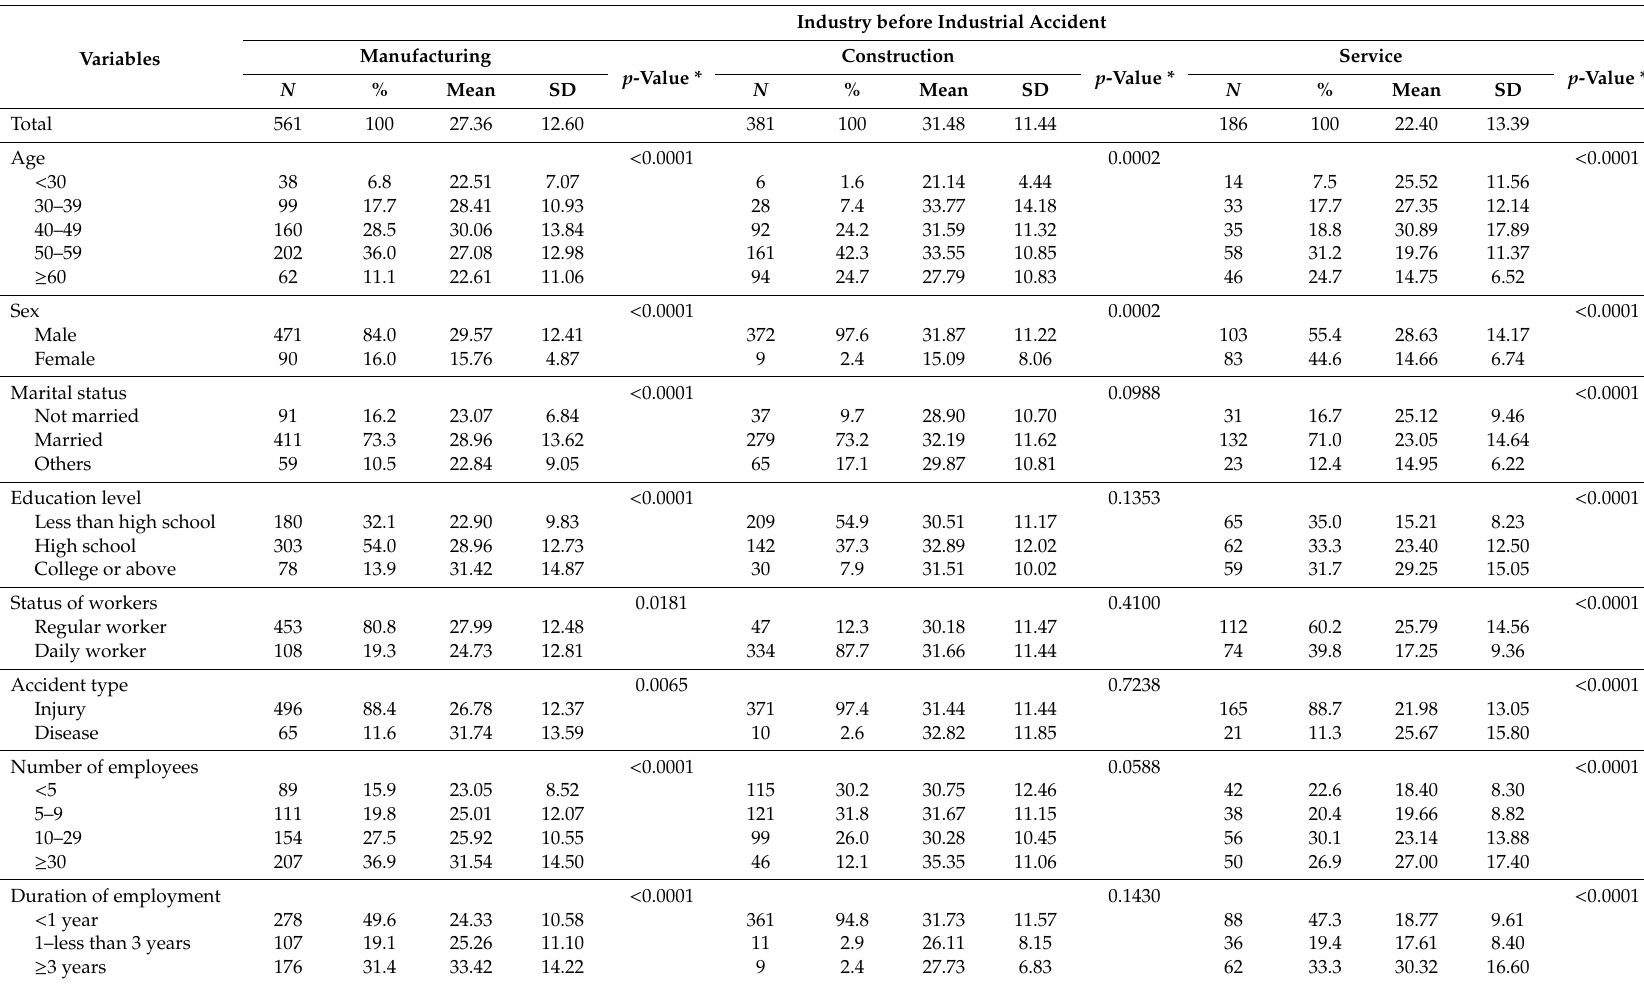
Table 1. General characteristics of study subjects by industry before industrial accident (unit: million